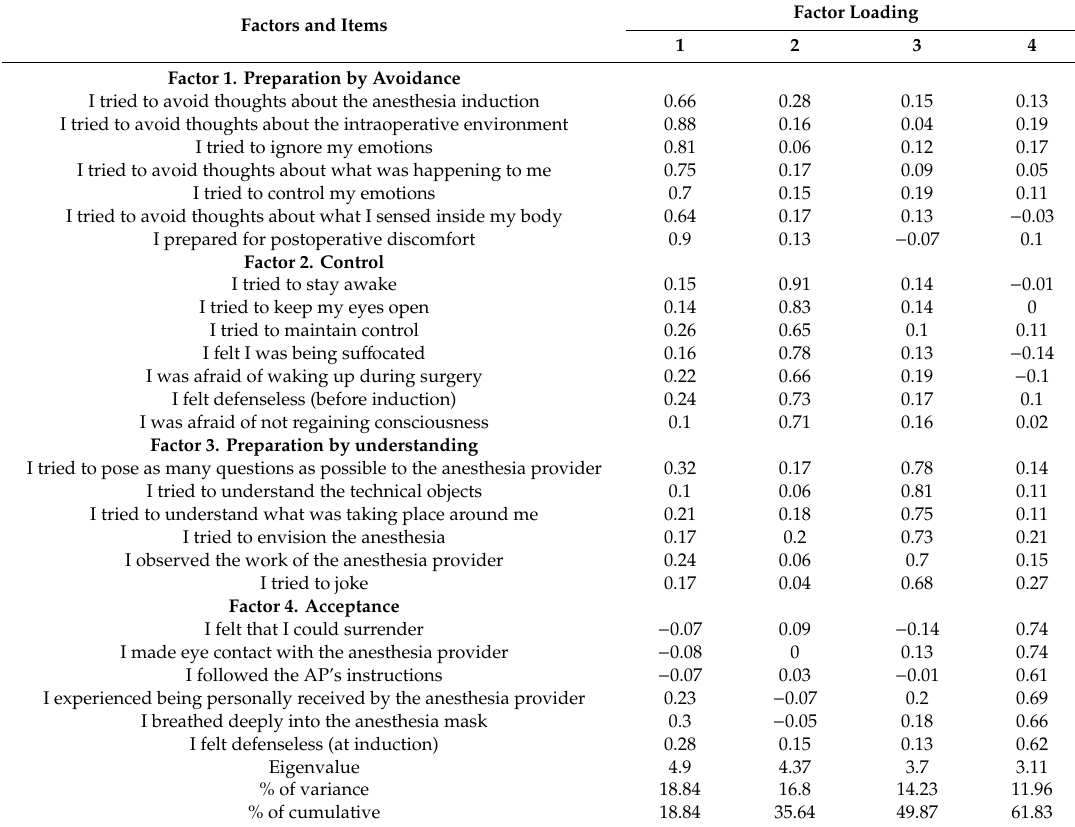
Table 2. Exploratory factor analysis of anesthesia surrendering instrument (N =